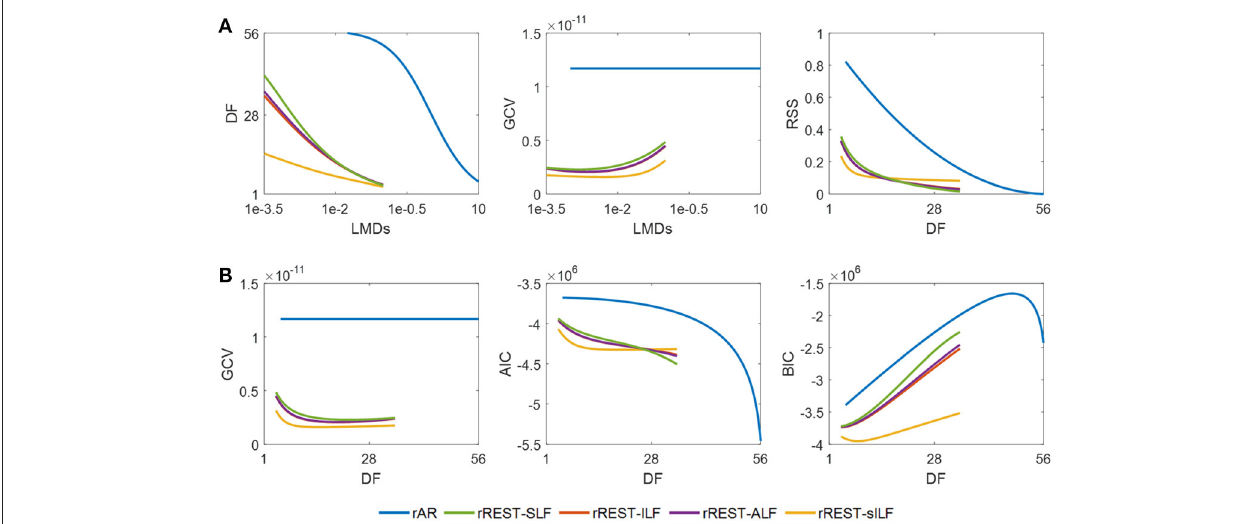
FIGURE 5 | Model selection with simulated data. DF, RSS, GCV, AIC, and BIC are the average over the 89 EEG data samples individually simulated with a different SNR among [5 20] dB. (A) , DF and GCV against LMD, and RSS varying with DF; (B) , model selection criteria (GCV, AIC, and BIC) against DF. DF, degree of freedom;